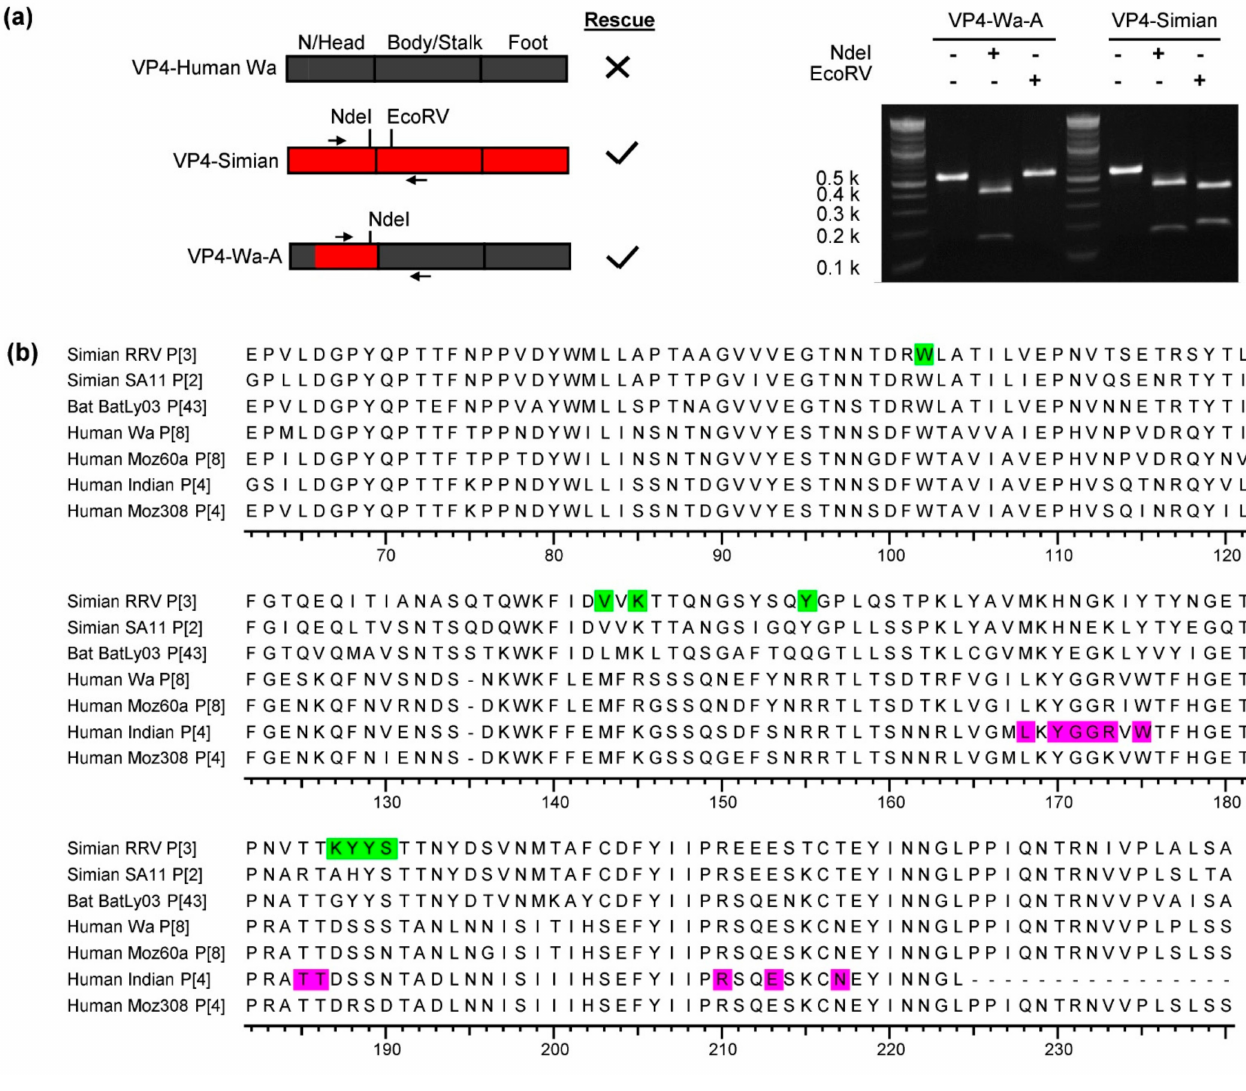
Figure 4. Chimeric simian/human VP4. N/Head: N-terminus and head region, human Wa: dark gray, simian SA11: red. ( a ) Agarose gel analysis of a restriction enzyme digestion of RT-PCR amplicons from VP4-Wa-A and VP4-Simian. The primer-binding sites and restriction sites are indicated left in the schematic overview of the different constructs. ( b ) Amino acid sequence alignment of the substituted head region. The sequences of simian RRV and a human Indian strain are included as their glycan-binding site are known. The known glycan-binding sites of simian RRV VP4 [38] and human Indian VP4 [14] are highlighted in green and purple,